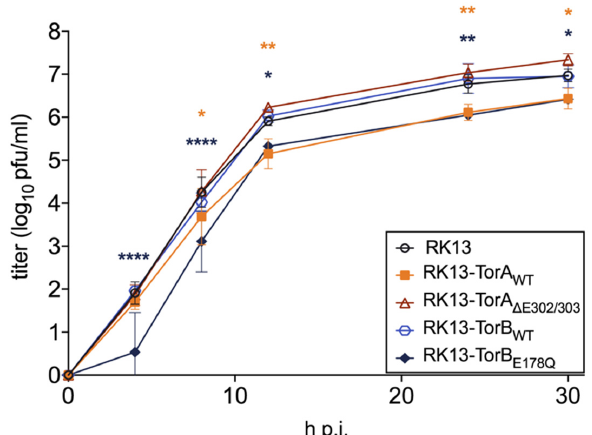
Figure 6. Effects of overexpression of Torsins on PrV replication. Stably expressing cell lines and parental RK13 cells were infected with PrV-Ka (MOI of 5) and harvested at different time points. Progeny virus titers were determined on RK13 cells. Given are mean values of three independent experiments with corresponding standard deviations. Statistically significant differences compared to the parental RK13 were determined by GraphPad Prism software and are indicated by asterisks in the same color as the corresponding graphs (*, p ≤ 0.05, **, p ≤ 0.01, ****, p ≤ 0.0001).